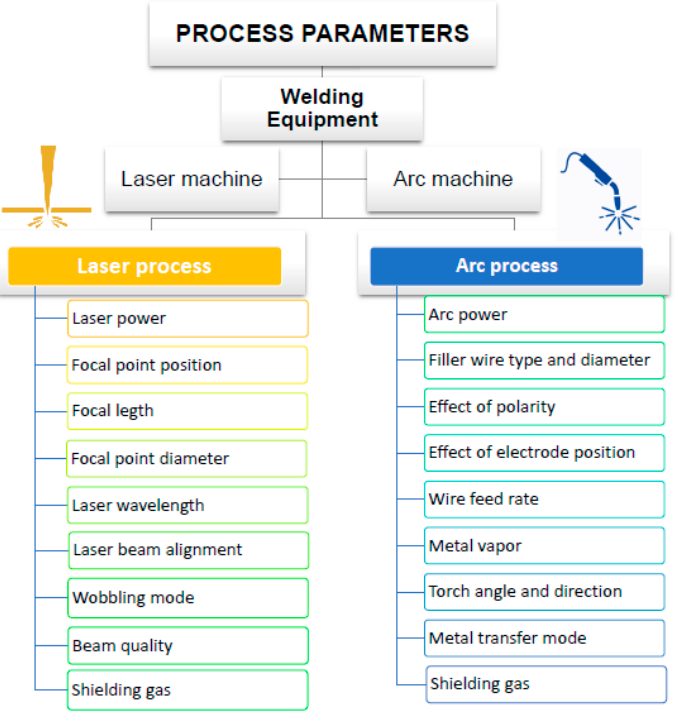
Figure 5. Flow chart of process parameters in LAHW [Adapted from 67].